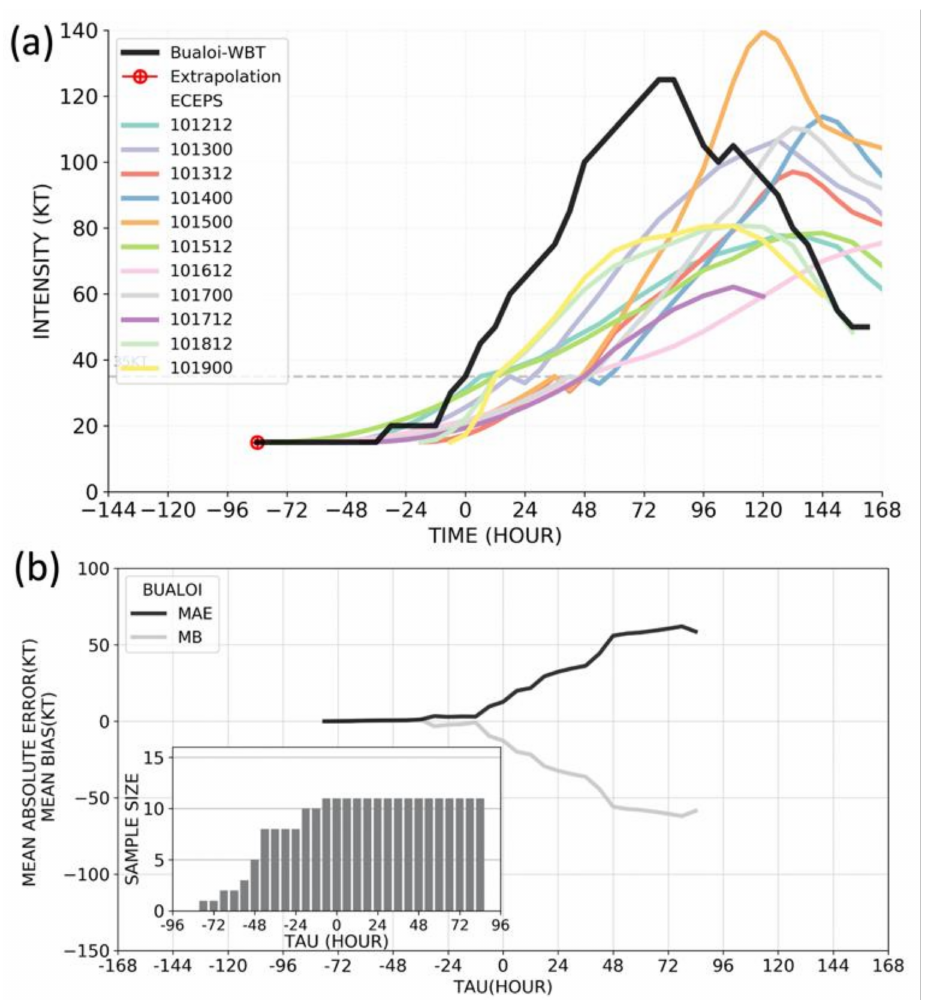
Figure 7. ( a ) Modified WAIP intensity (knots) forecast verifications for the ECEPS-predicted T2F (35 kt) as in Figure 4b, except for the pre-TY Bualoi (2019) circulations. ( b ) Intensity MAEs (solid line) and intensity MBs (gray line) as in Figure 4d,f except for pre-TY